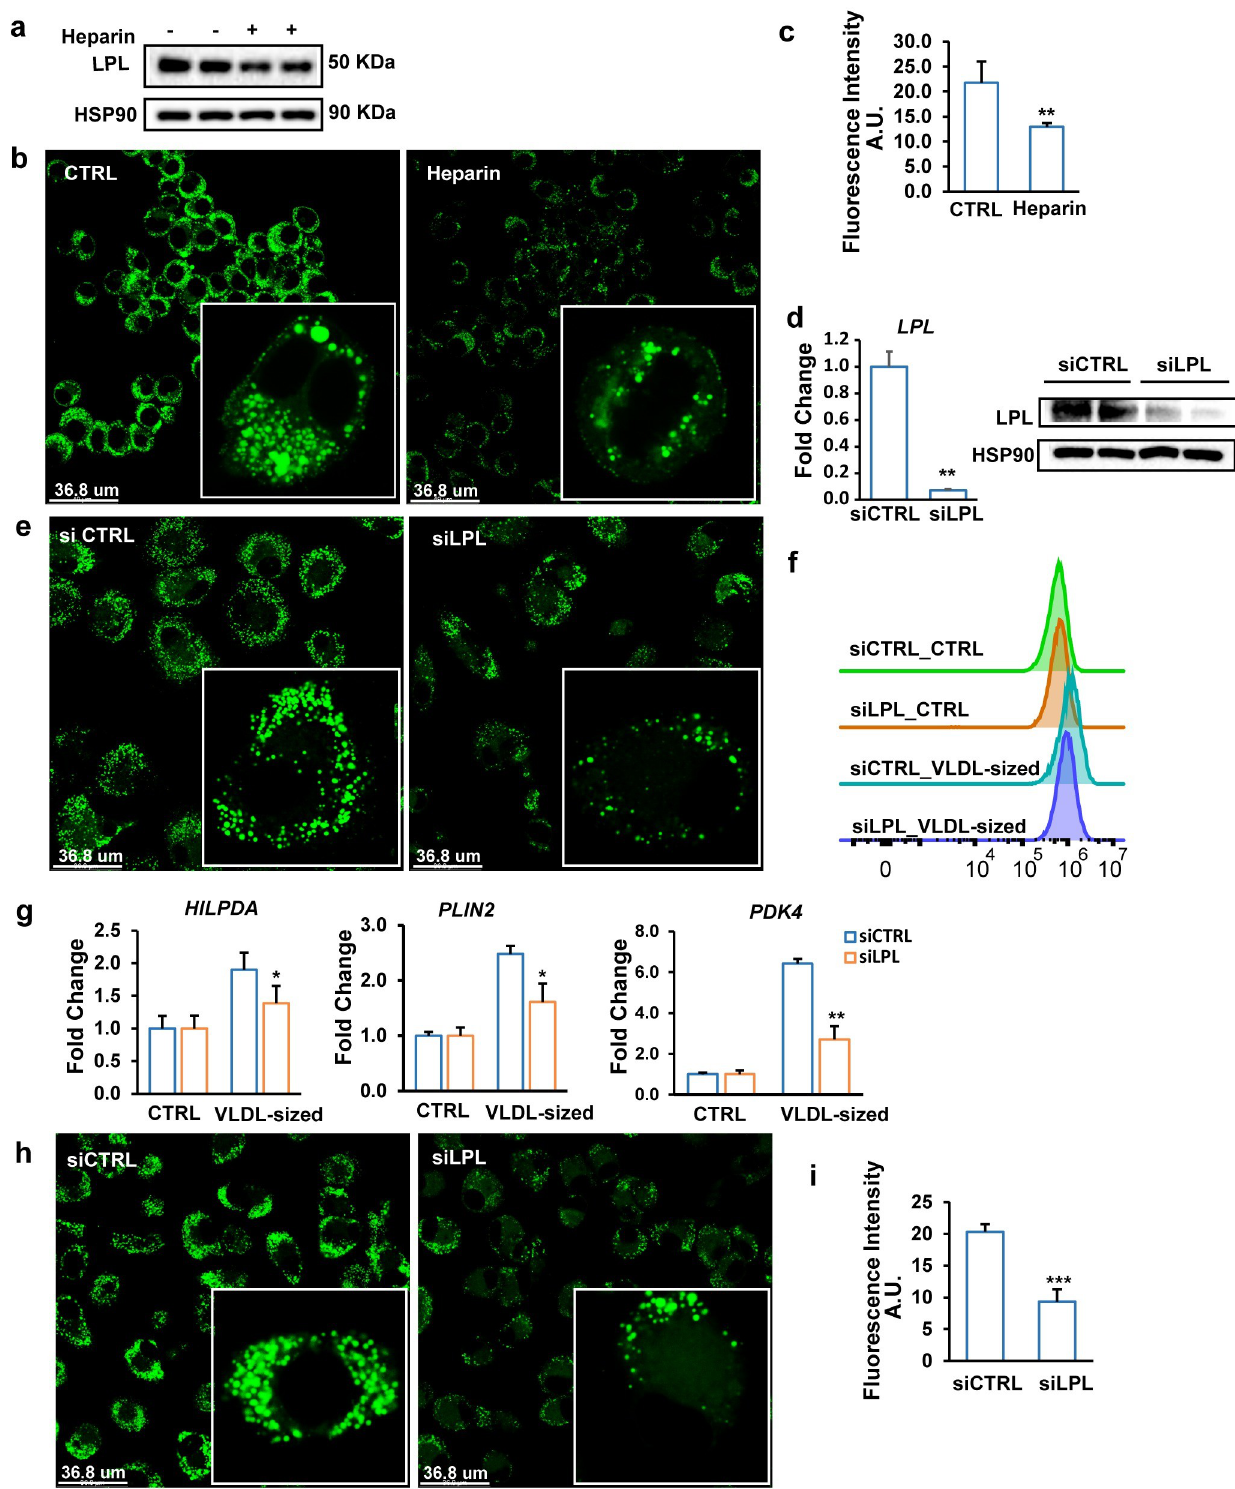
Fig 2. LPL mediates VLDL uptake in cultured macrophages. (a) LPL protein levels in RAW 264.7 macrophages treated with 50 UI/ml heparin for 2 hours. (b) BODIPY 493/503 staining of intracellular neutral lipids in RAW 264.7 macrophages treated with 1 mM VLDL-sized emulsion particles for 6 hours in the presence or absence of 50 UI/ml human heparin ( n = 6). (c) Quantification of the fluorescence images by ImageJ ( n = 6). (d) LPL mRNA and